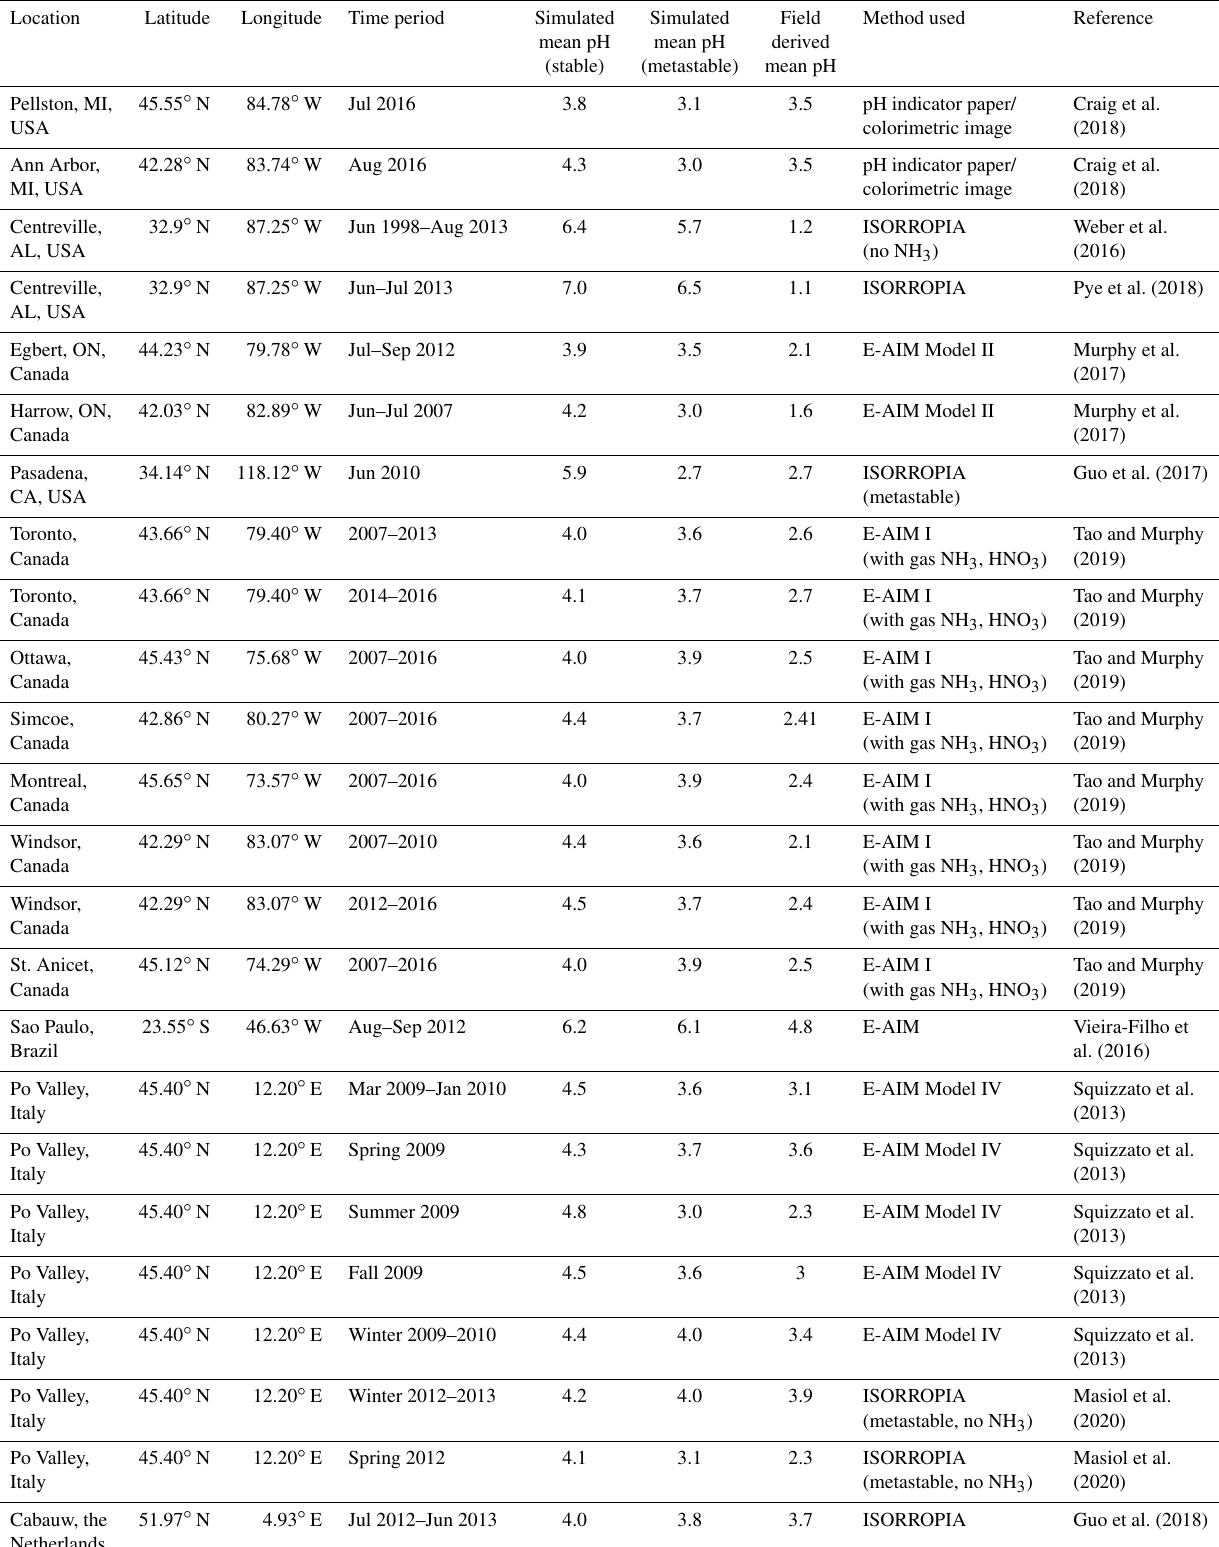
Table A1. Simulated fine aerosol particle pH compared to observationally constrained estimates of fine particle acidity compiled by Pye et al.